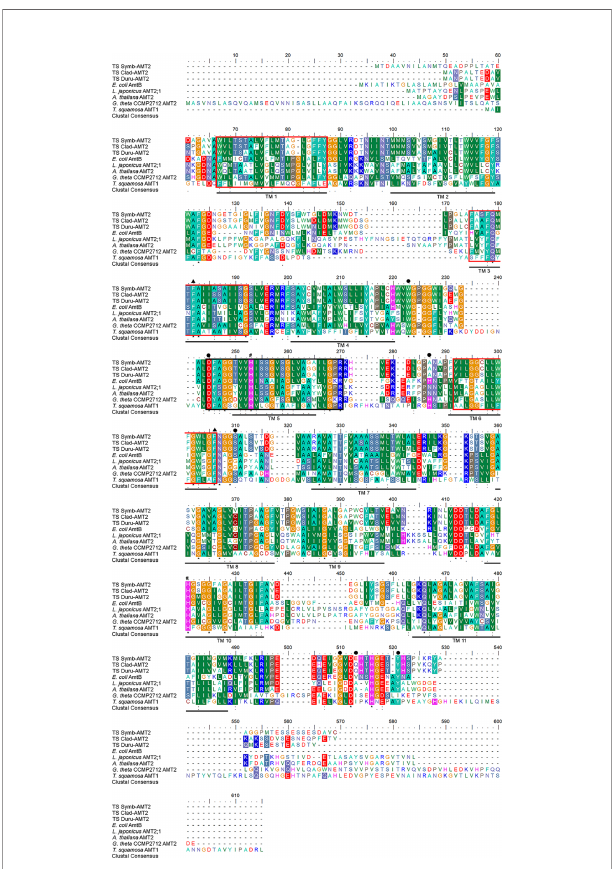
FIGURE 1 | Molecular characterization of the deduced amino acid sequences of ammonium transporter 2 (AMT2) from Symbiodinium (Symb-AMT2), Cladocopium (Clad-AMT2), and Durusdinium (Duru-AMT2) obtained from the outer mantle of Tridacna squamosa. Multiple alignment of Symb-AMT2 (MW023800), Clad-AMT2 (MW023801), and Duru-AMT2 (MW023802) with Escherichia coli AmtB (AAD14837.1), Lotus japonicus AMT2;1 (AAL08212.1), Arabidopsis thaliana AMT2 (AEC09519.1), Guillardia theta CCMP2712 AMT2 (EKX43695.1), and T. squamosa AMT1 (ATC20499). Identical or similar amino acid residues are shaded. Asterisks, colons and periods denote identical amino acid residues, strongly similar amino acids and weakly similar amino acids, respectively. The eleven predicted transmembrane regions (TM 1-TM 11) predicted using MEMSAT3 are underlined in black. The pore lining amino acid residues predicted MEMSAT- SVM were indicated with red boxes. The conserved amino acid residues involved in the binding of NH 4+ and the phenylalanine gate are marked with closed circles and triangles, respectively. The conserved histidine residues involved in the deprotonation of NH 4+ are demarcated by the pound sign. The AMT signature pattern (D 160